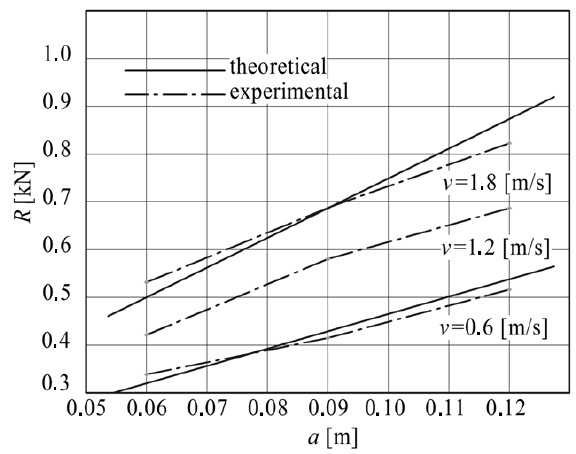
Figure 17. The regularity of the change in the tractive resis– tance of the sowing section (with the slotting disk) R depe– nds on the working speed and the tilling depth of the colter at P 5 = 1.0kN